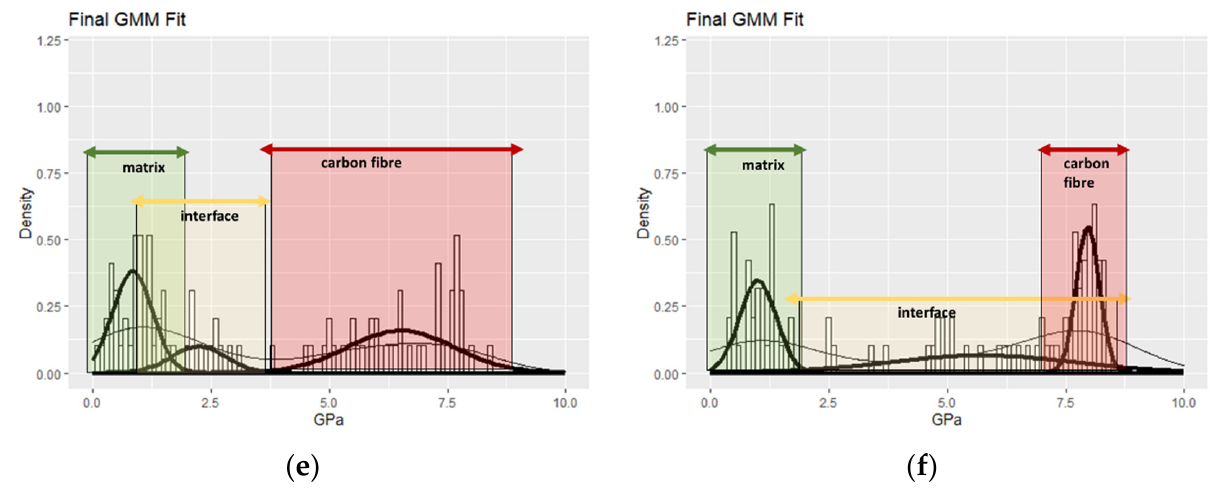
Figure 9. Phase quantification with Probability Distribution Fitting (PDF) of nanoindentation hardness for ( a ) pristine, ( b ) W-pristine, ( c ) PMAA, ( d ) W-PMAA, ( e ) APP, ( f ) W-APP specimen.